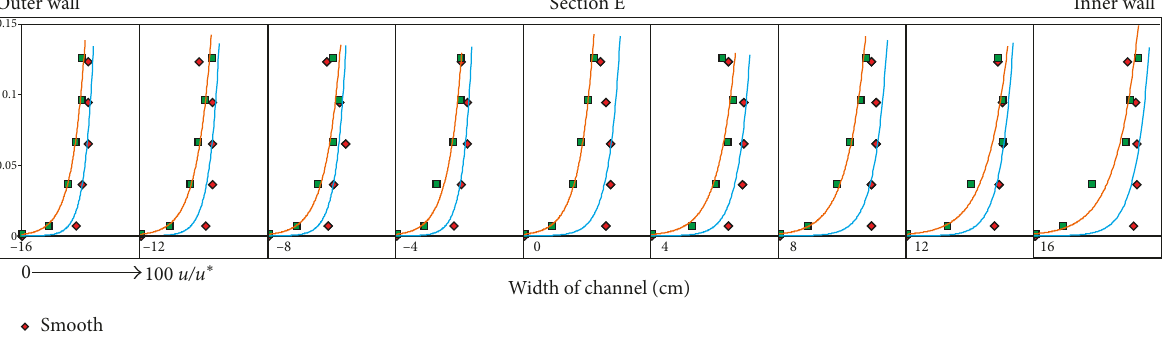
Figure 8: Comparison of velocity variation in section E.